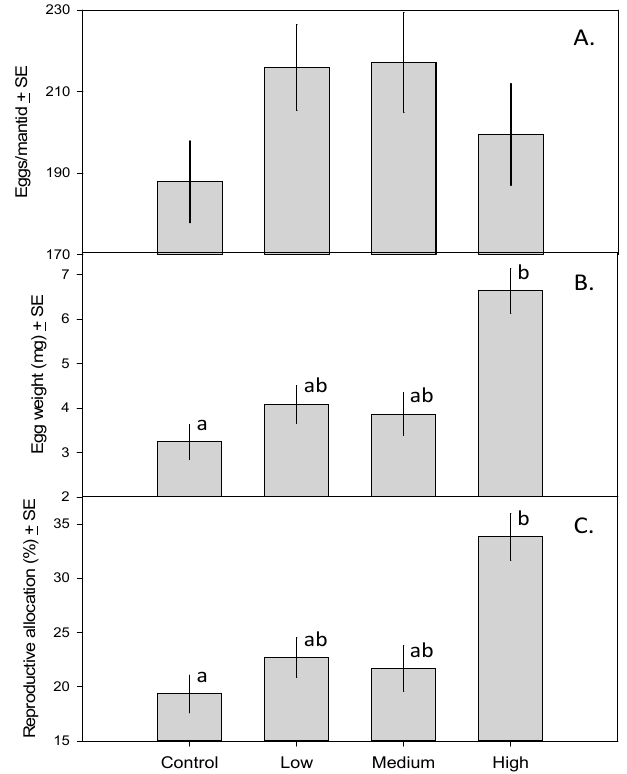
Figure 2. ( A ) Number of eggs produced by mantids fed zero, one, five, or 15 monarch caterpillars ± SE; ( B ) Mean mantid egg weight (mg) ± SE; ( C ) Percent mantid biomass composed of eggs ± SE. Means with different letters are significantly